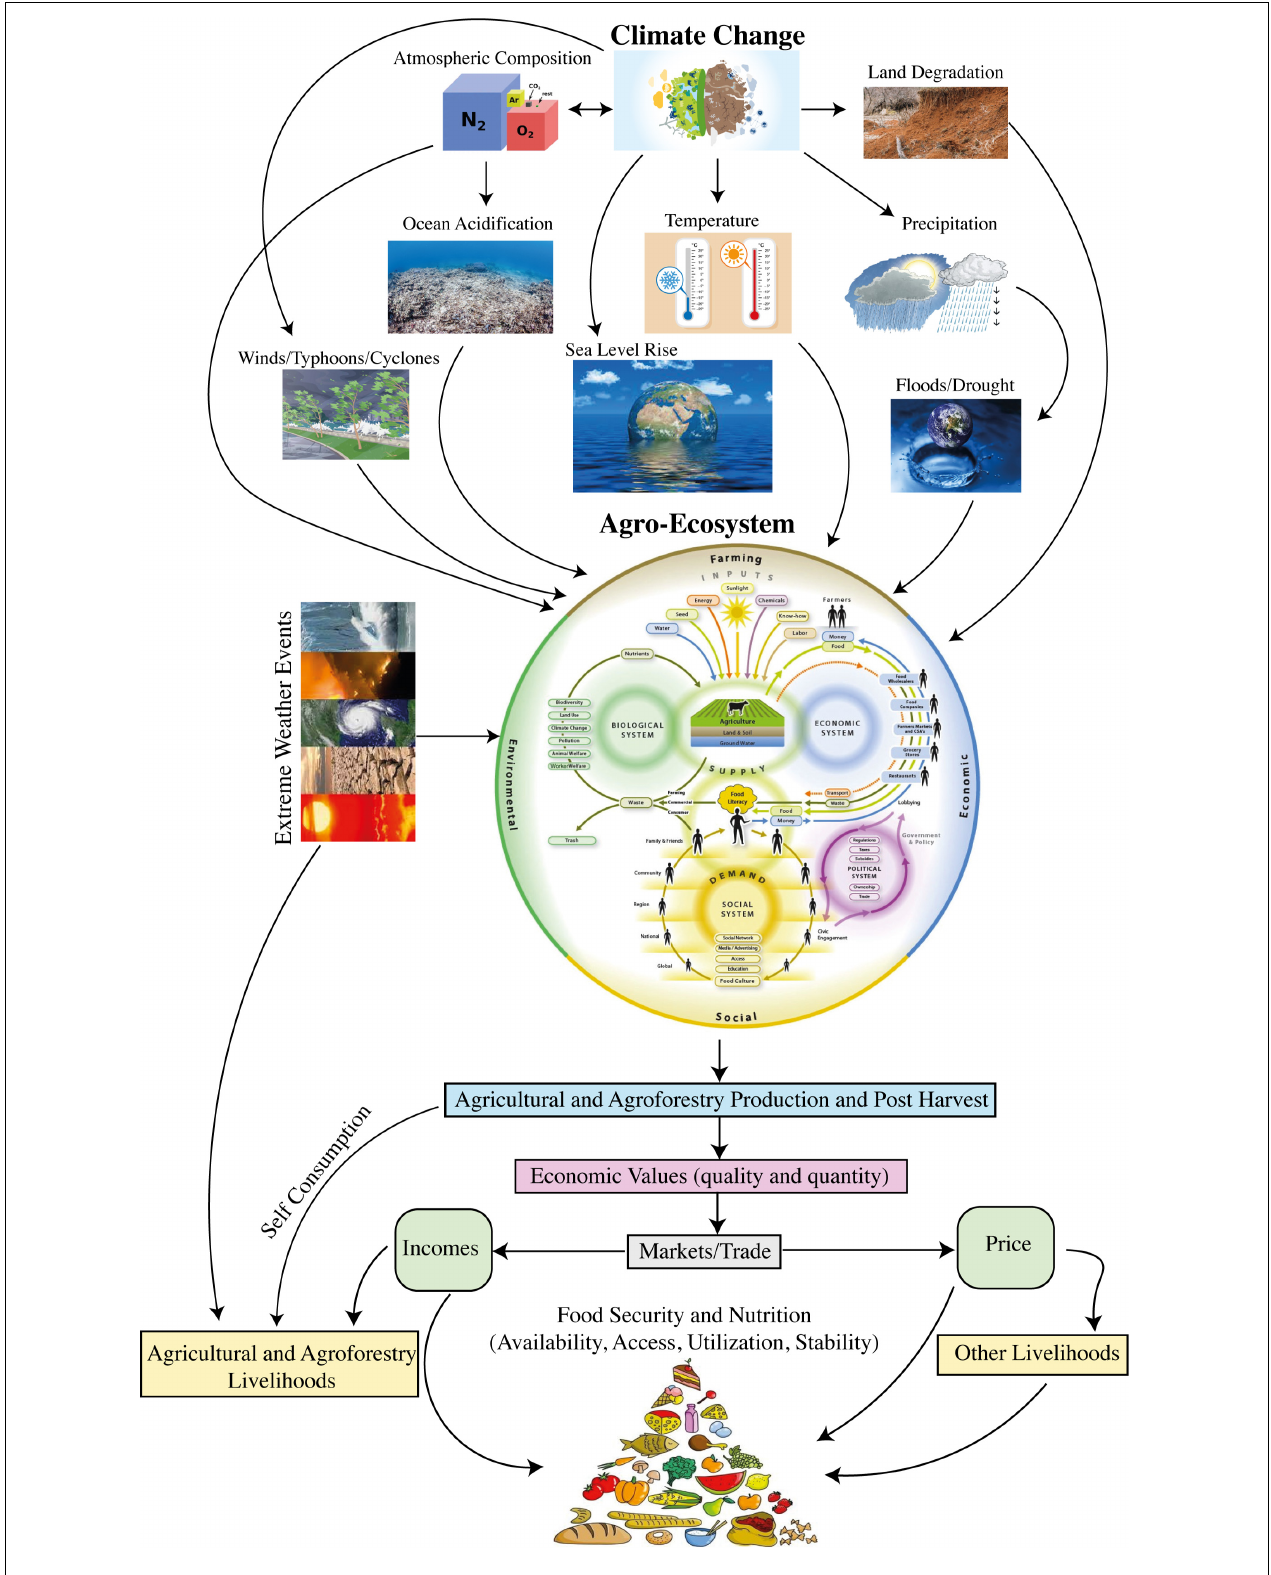
FIGURE 1 | Schematic representation of climate change impacts on global food security and nutrition.